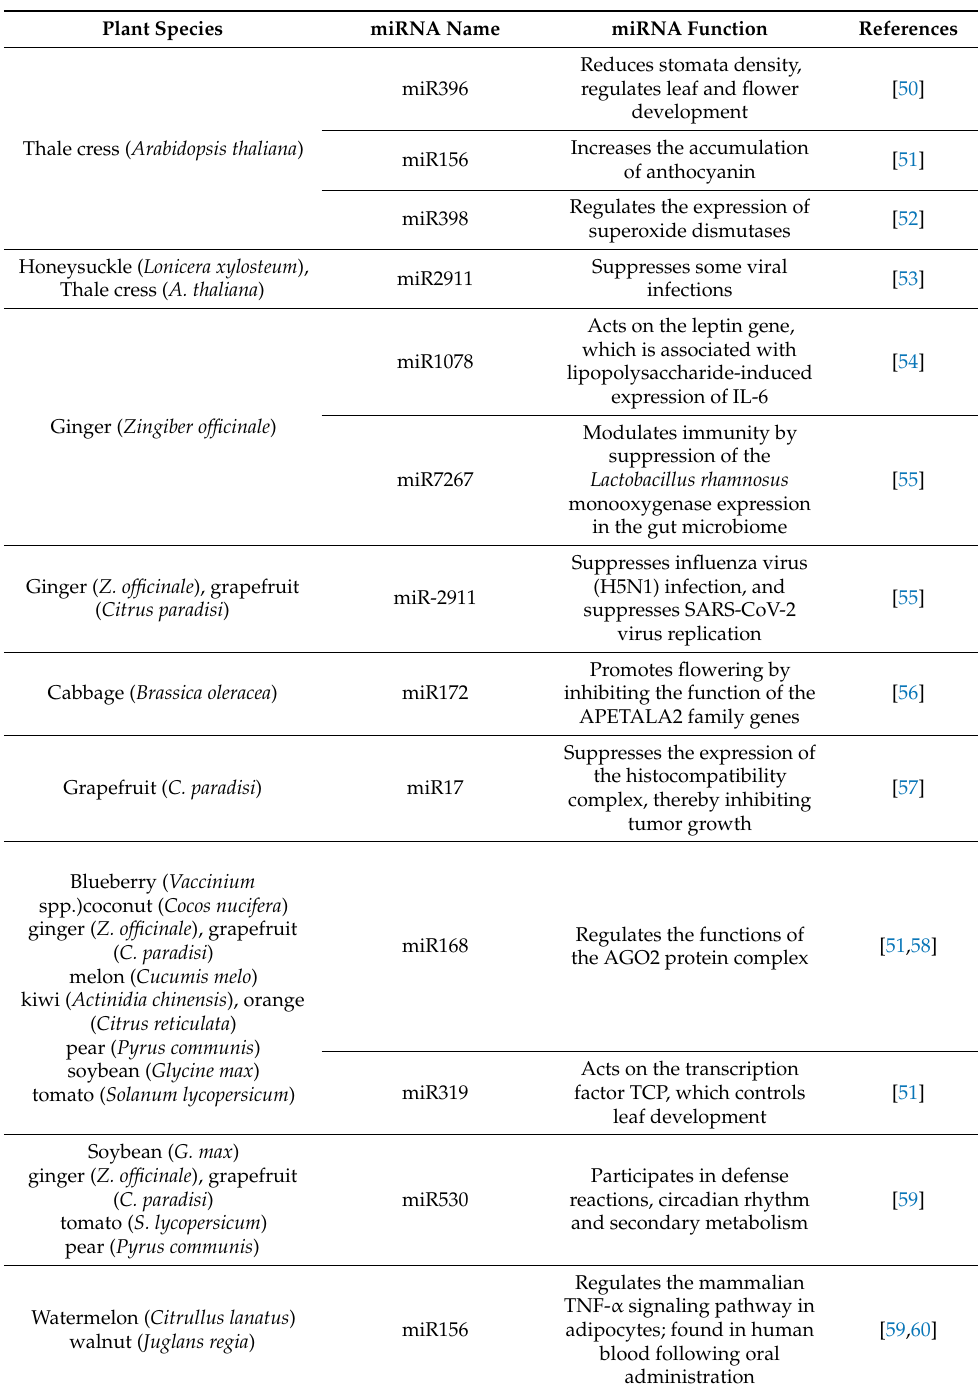
Table 2. Examples of miRNAs in plant